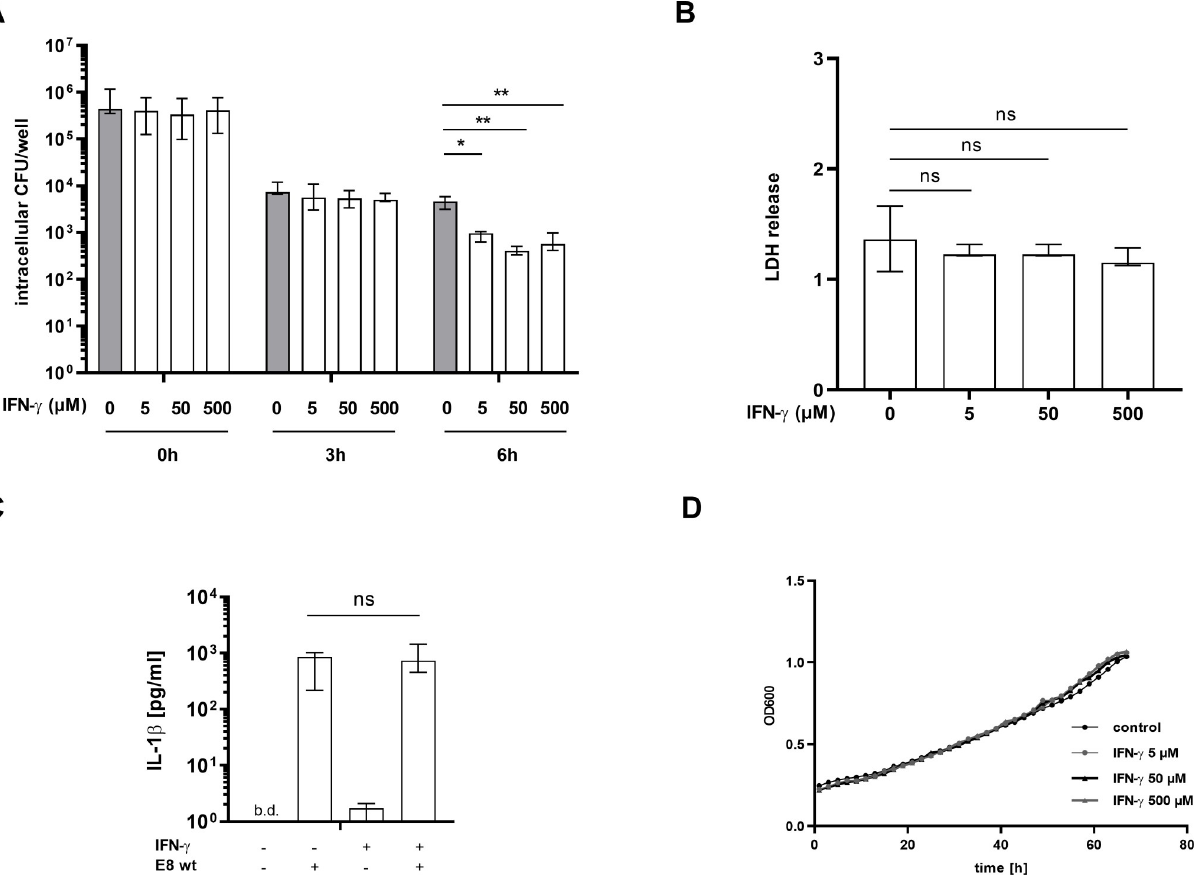
Fig 4. IFN- γ contributes to cytosolic restriction of B . pseudomallei in hMDMs. hMDMs were infected with B . pseudomallei (MOI 300) in the absence or presence of IFN- γ (5, 50 or 500 μ M). (A) Cells were lysed 0, 3 or 6h p.i. and intracellular bacterial burden was measured. Graphs show the median with interquartile range of four independent experiments with different donors performed in duplicates. ( � p < 0.05, �� p < 0.01). (B) Induction of pyroptosis was measured by LDH release in supernatants 6h p.i. Graphs show the median with interquartile range of three independent experiments with different donors performed in duplicates. (C) IL-1 β release was measured 6h p.i. in the presence or absence of 500 μ M IFN- γ . Graphs show the median with interquartile range of three independent experiments with different donors performed in duplicates. (D) Growth analysis of the wt in media with different concentrations of IFN- γ was performed. Data are represented as mean of three independent experiments performed in duplicates. wt (wild type), b.d. (below detection), hours (h), p.i. (post infection), ns (not significant).